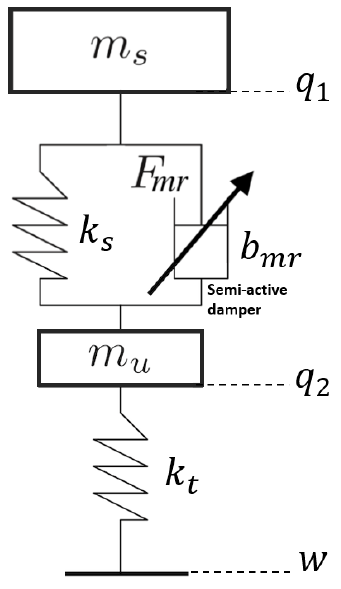
Figure 1. Quarter-car